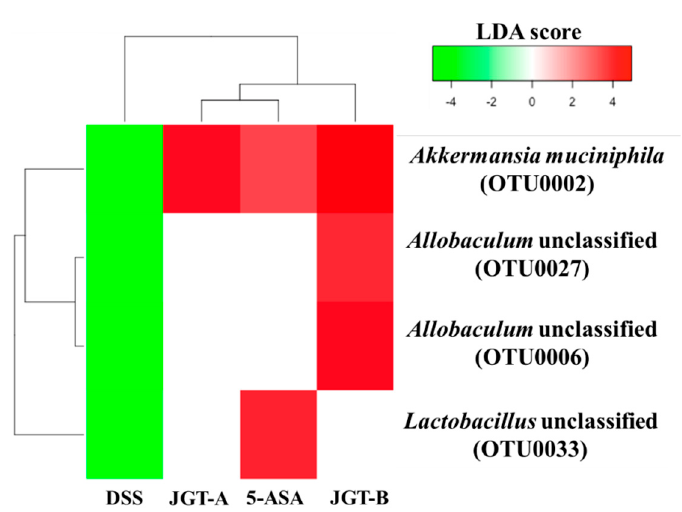
Figure 3. Heatmap analysis of OTUs that were significantly decreased by DSS treatment but significantly increased by treatments based on LEfSe results (LDA > 3, p < 0.05). DSS and control groups were compared to identify OTUs that were significantly decreased by DSS. DSS and treatment groups were compared to identify OTUs that were significantly increased by treatments.